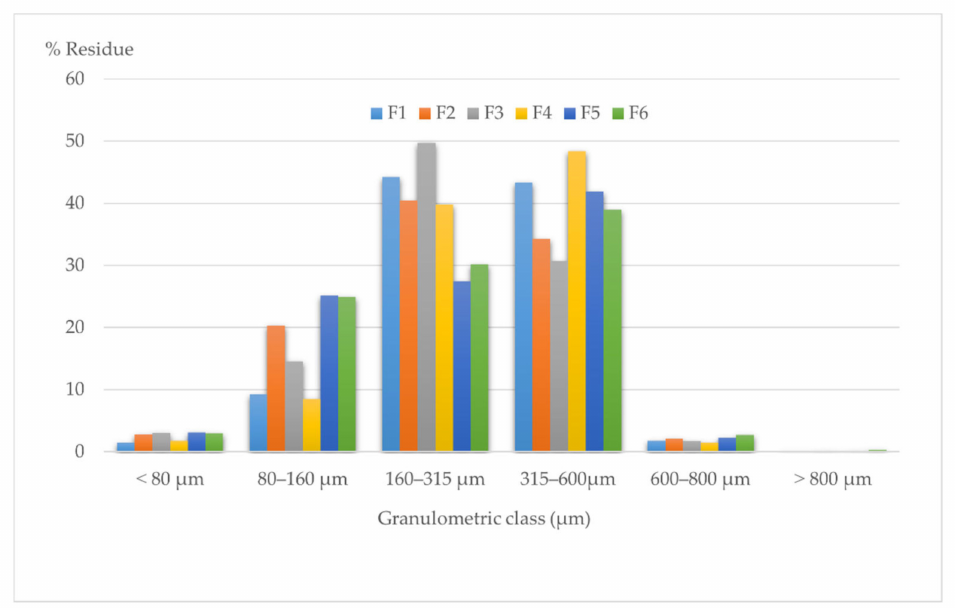
Figure 13. Granulometric analysis of the direct compression blends. The histogram plot displayed the differences in particle sizes between the